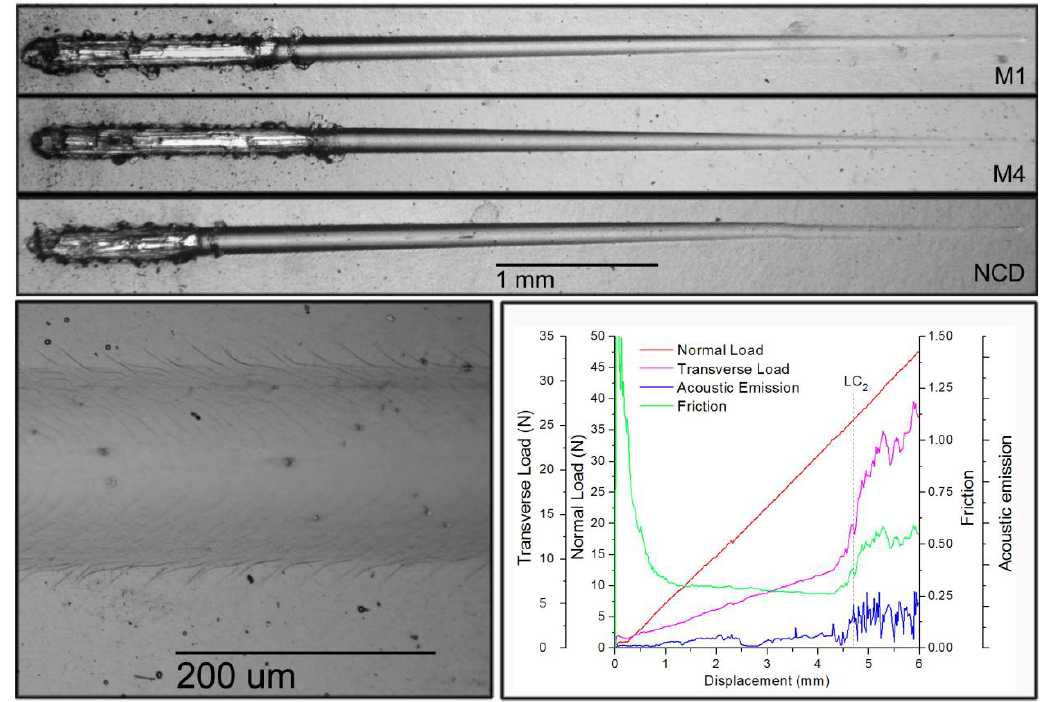
Figure 8. ( a ) Representative scratch track of M1, M4, and NCD samples tested on Ti-6Al- 4V substrates; ( b ) Higher magnification of NCD sample showing forward tensile cracking attributed to cohesive failure in coating; ( c ) Sample data output for NCD coated